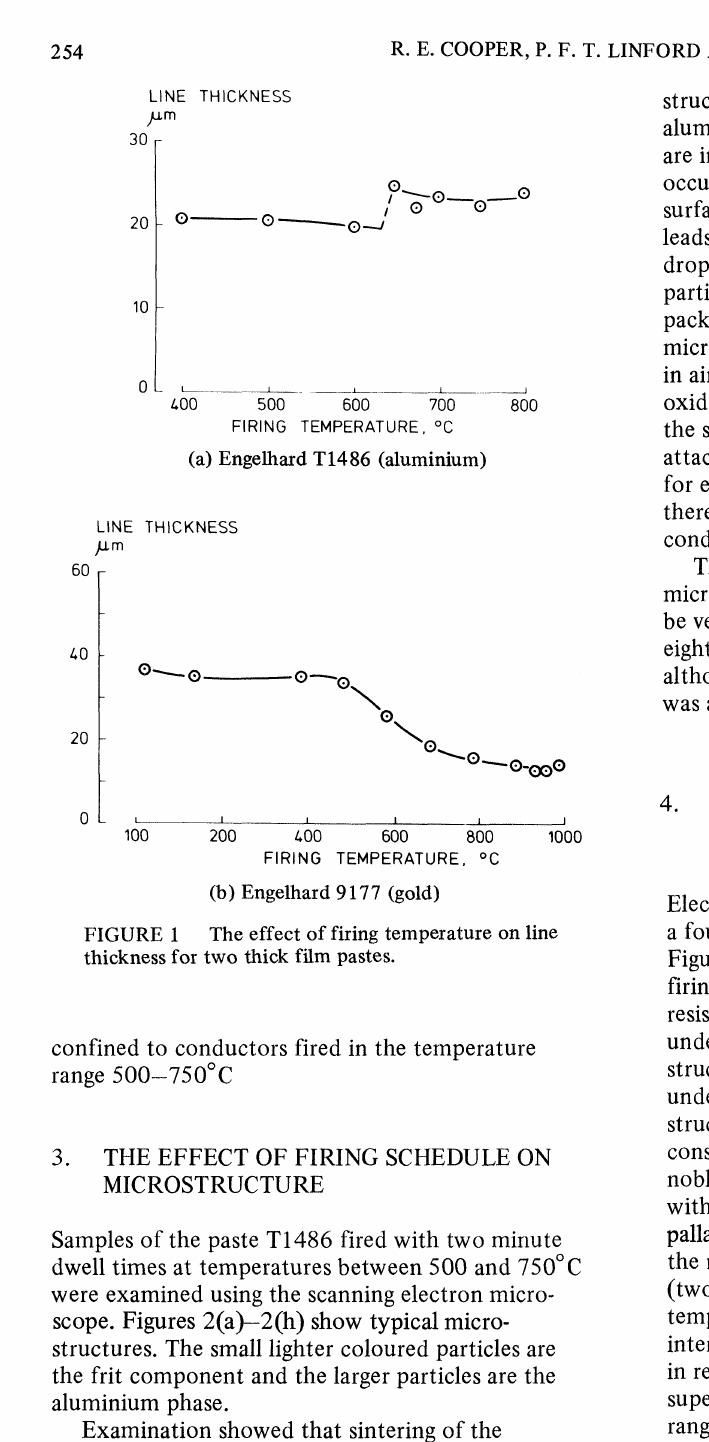
confined to conductors fired in the temperature range